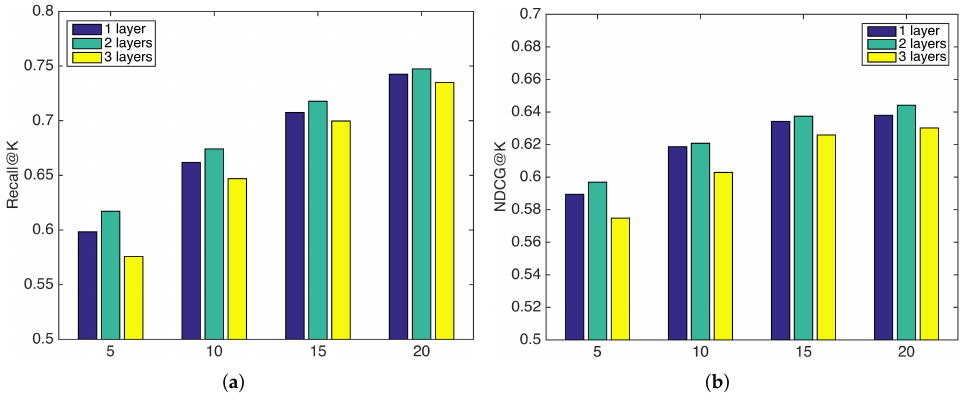
Figure 5. Impact of propagation layer number in GCN. ( a ) Recall@K; ( b ) NDCG@K.